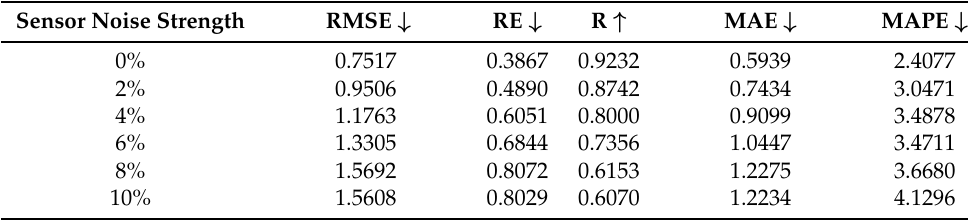
Table 9. Quantitative analysis on different strengths of additional sensor noises.